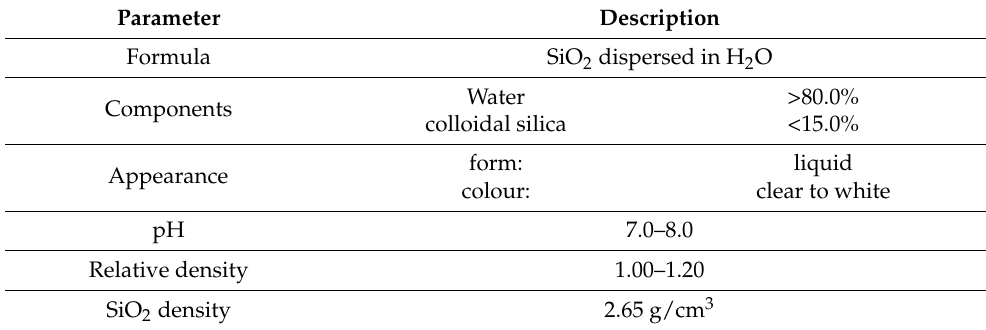
Table 1. Properties of the liquid silica marker used in the